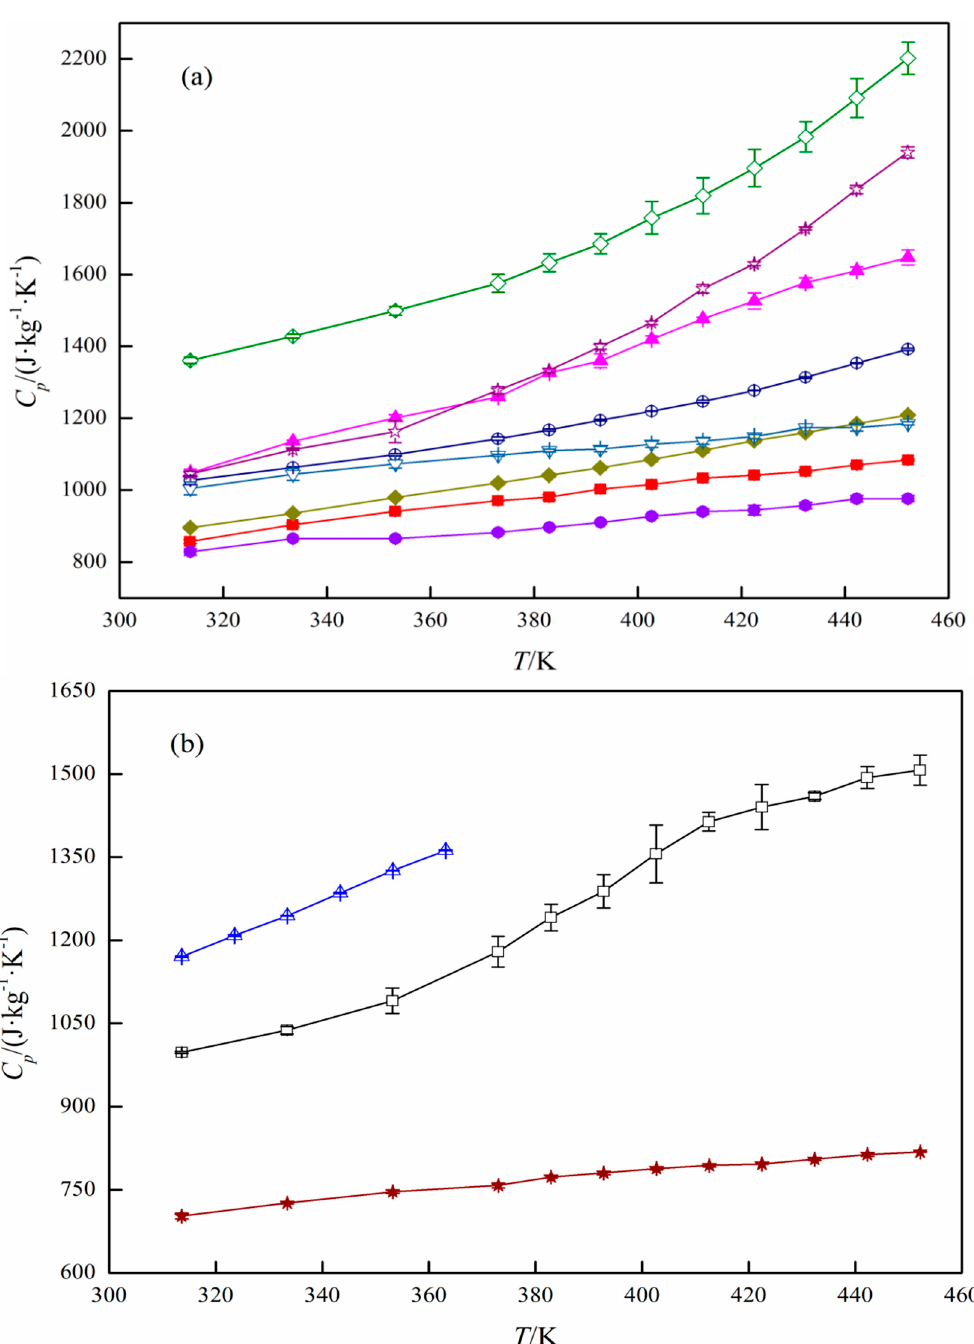
Figure 3. C p values of ( a ) catalytic materials containing alumina or silica, and ( b ) other catalytic materials as a function of temperature. □ , activated carbon; ■ , Al 2 O 3 ; △ , amberlite IR120, H-form; ▲ , H-Beta-25; ◇ , H-Beta-38; ◆ , H-Y-60; ○ , H-ZSM-5-23; ● , H-ZSM-5-280; ☆ , SiO 2 ; ★ , TiO 2 ; ▽ , zeolite